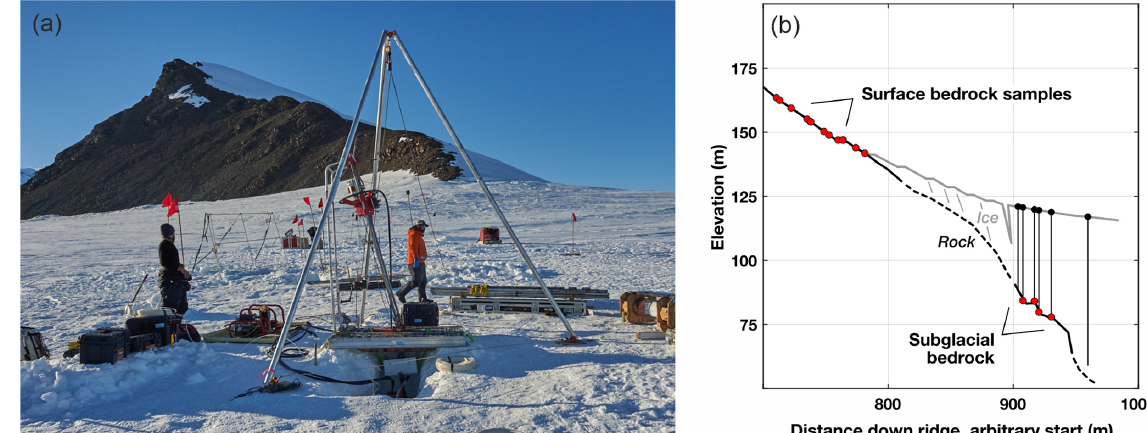
Figure 5. An example of subglacial bedrock drilling in Antarctica. (a) Photograph showing an attempt to collect subglacial bedrock samples for OSL and cosmogenic 14 C measurements to determine whether a late Holocene thinning–thickening cycle took place at Mt Murphy, between the Thwaites and Pope glaciers in West Antarctica. (b) Plot showing profile along the ridge at Mt Murphy. Red circles denote position of surface and subglacial bedrock samples. The lowermost bedrock samples on the exposed ridge above the present ice surface have exposure ages of 4ka (Johnson et al., 2020), leaving a late Holocene time gap during which the ice at this location could have been thinner. Drilling to collect subglacial bedrock samples took place in the 2019–2020 Antarctic field